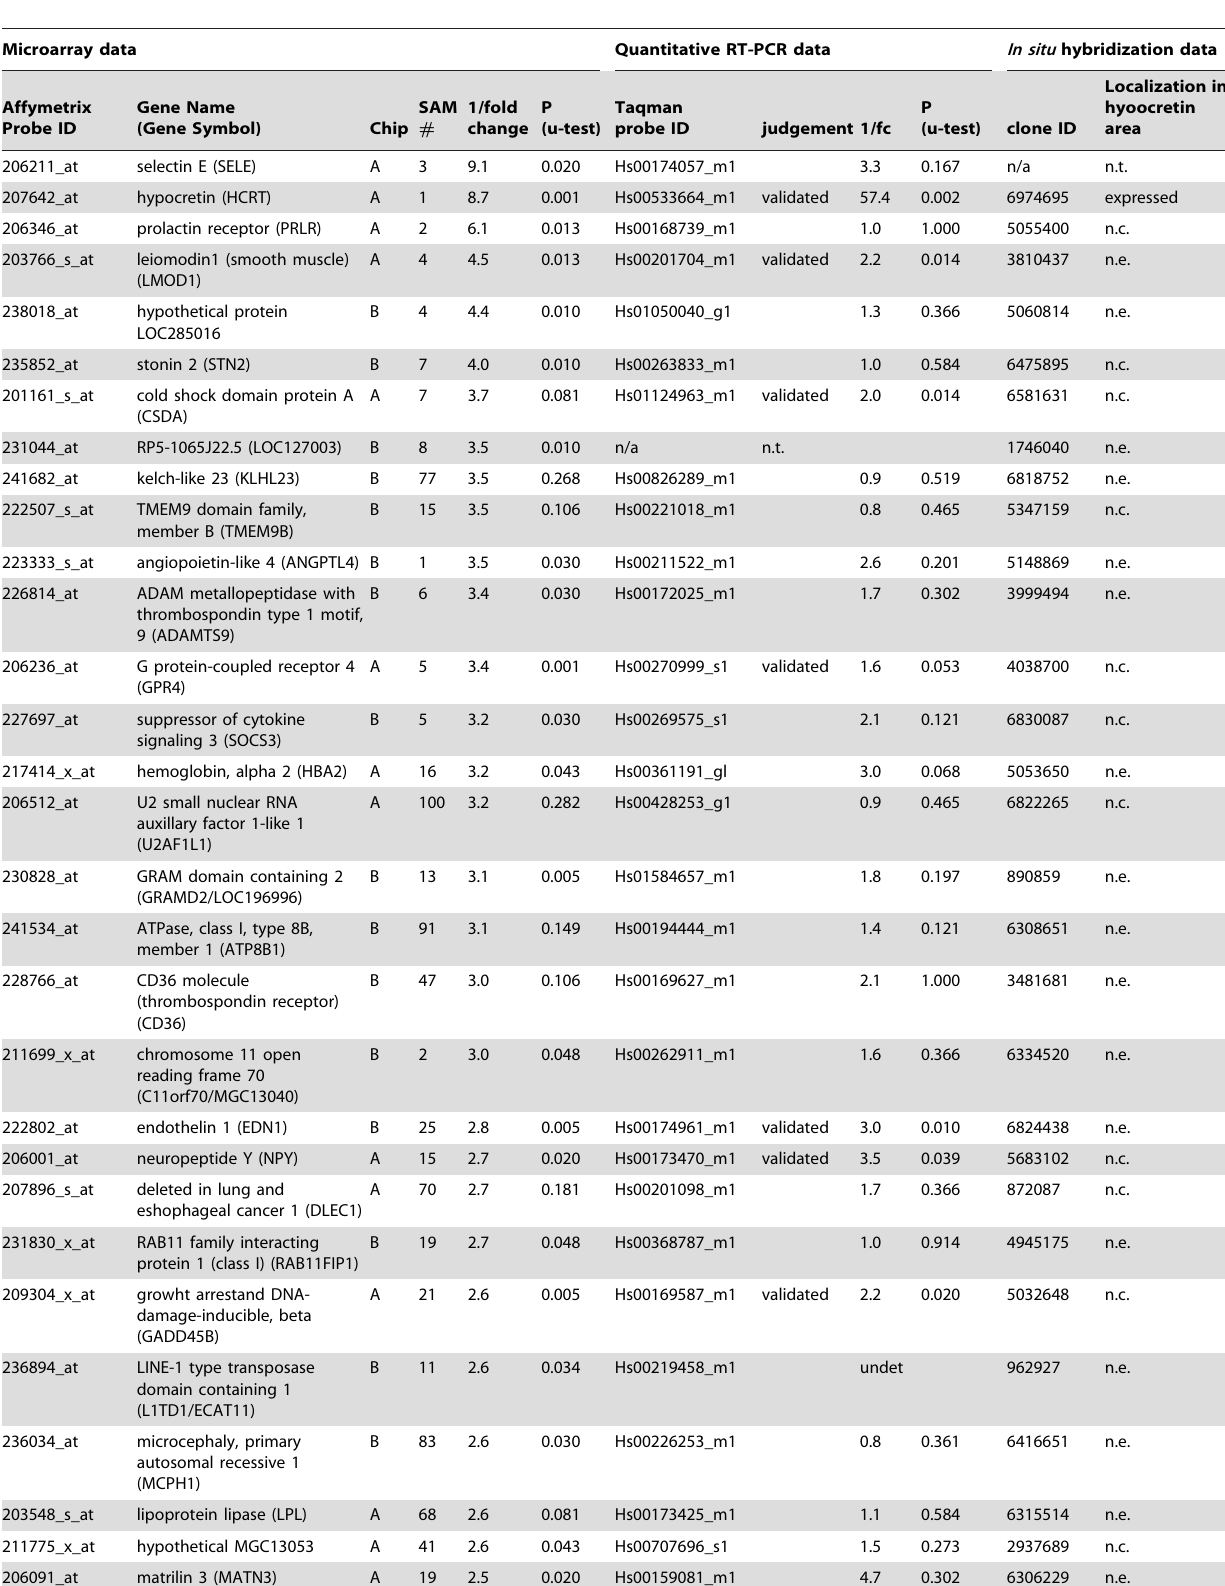
Table 2. Human narcolepsy susceptibility candidate genes analyzed by microarray, quantitative RT-PCR and distribution shown by in situ hybridization in